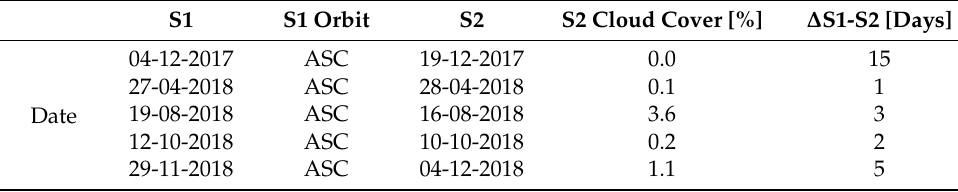
Table 1. Sentinel-1 (S1) and Sentinel-2 (S2) imagery used in this research. S1 S1 Orbit S2 S2 Cloud Cover [%] ∆ S1-S2